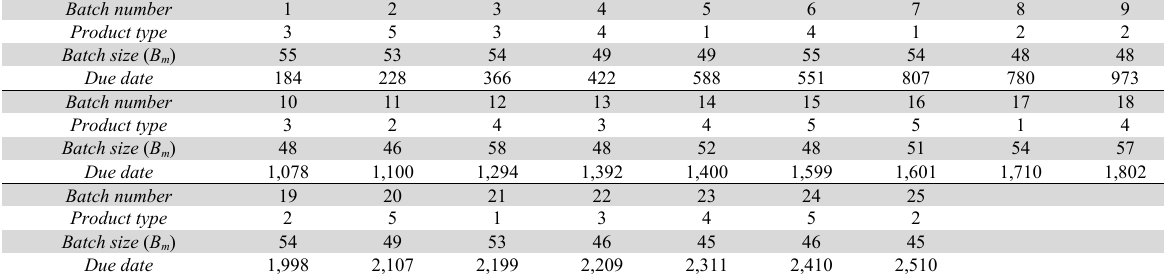
Table 3 The data of Batches Batch